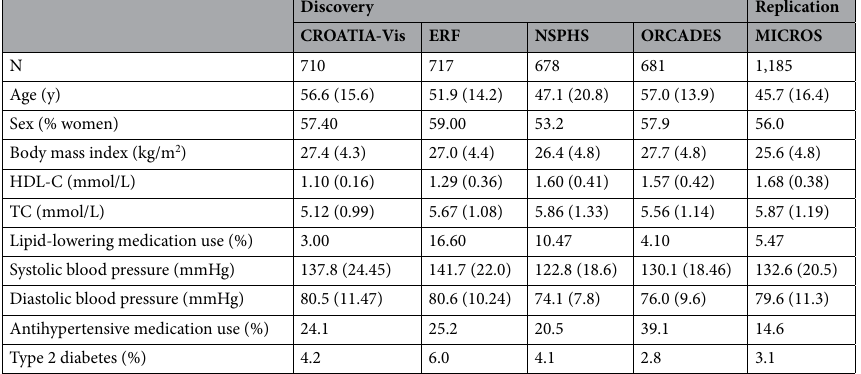
Table 1. Baseline characteristics of the study population in the association analysis. Values are mean (SD) or percentages. N refers to the largest sample size used in this study.